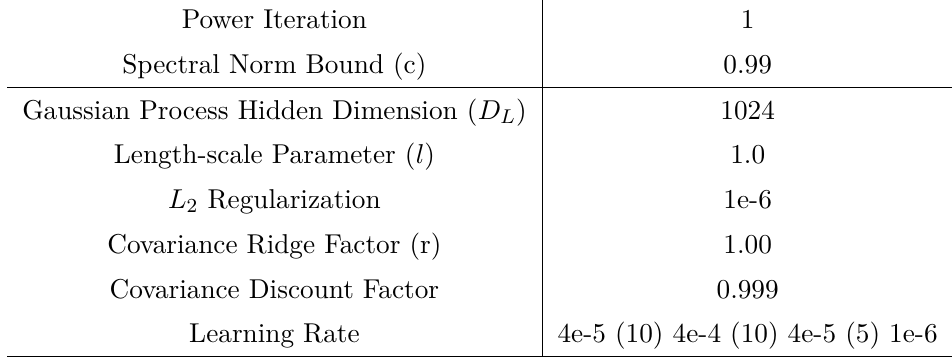
Table 5 . SNGP hyper-parameters. For the learning rate, we linearly increase it to the target value of 4e-4 and then decrease it to the initial value of 4e-5. Finally, we decrease the rate to 1e-6, and train for a few more epochs to ensure convergence. The numbers in brackets are epochs taken to finish the rate